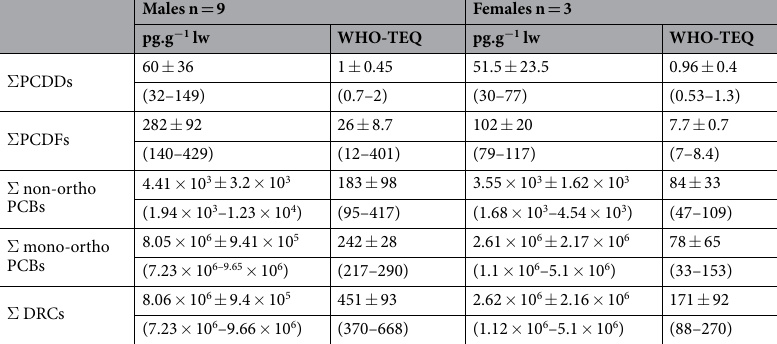
Table 2. Dioxin-related compounds (DRC, pg.g − 1 lw and pg WHO-TEQ.g − 1 lw) in the blubber biopsies of bottlenose dolphins from the Normanno-Breton Gulf. The data are presented as the mean ± the standard deviation (min–max values) and the number of individuals (n).